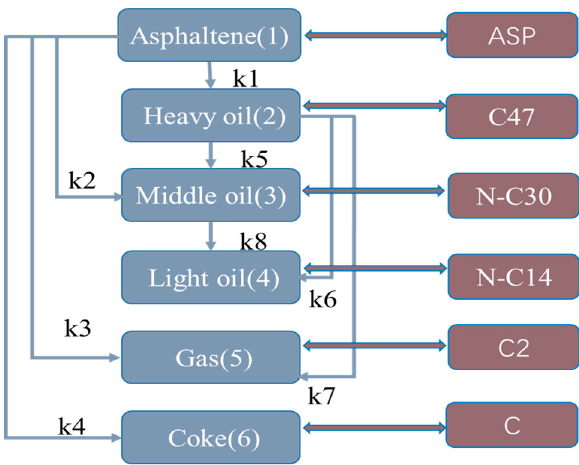
Figure 4. Kinetic scheme for the six-lump model of asphaltene hydrogenation.